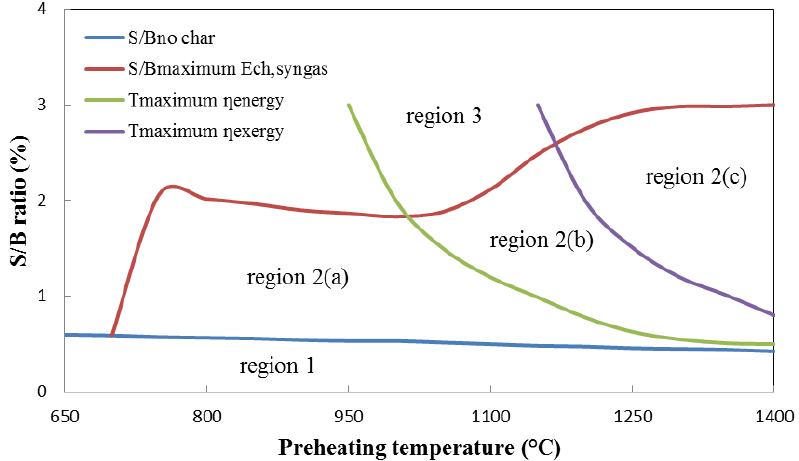
Figure 9. Definition of possible operating regions for the HTAG